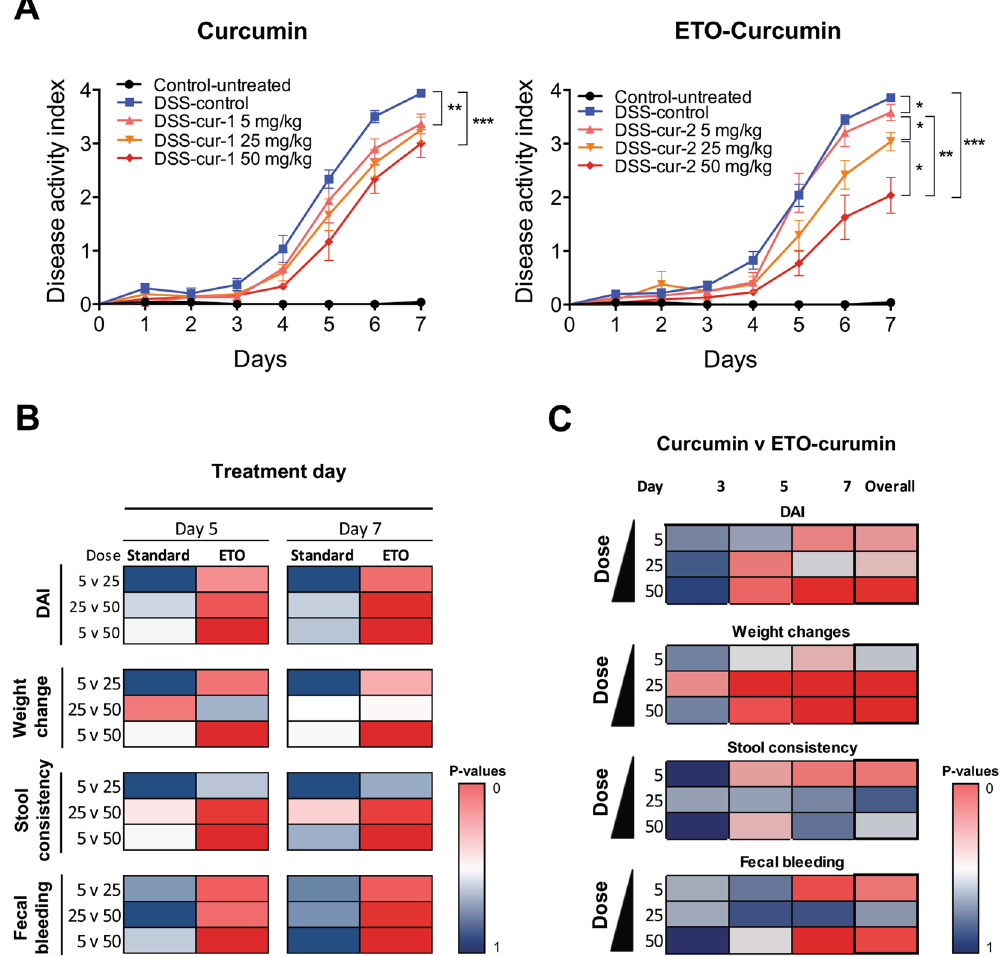
Figure 3. Dose-dependent comparison between standard curcumin and ETO-curcumin on disease activity index (DAI). ( A ) DAI of standard curcumin (left) and ETO-curcumin (right) according to their doses. ( B ) Graphical representation of comparison of doses within the treatment group at DSS treatment days 5 and 7 for DAI and DAI associated parameters. ( C ) Graphical representation of comparison between standard curcumin and ETO-curcumin at individual doses (5, 25, 50 mg/kg) on DSS treatment days 3, 5, 7 and cumulative comparsion. For both panel B and C red cells represent significant difference between groups, while blue represents similar